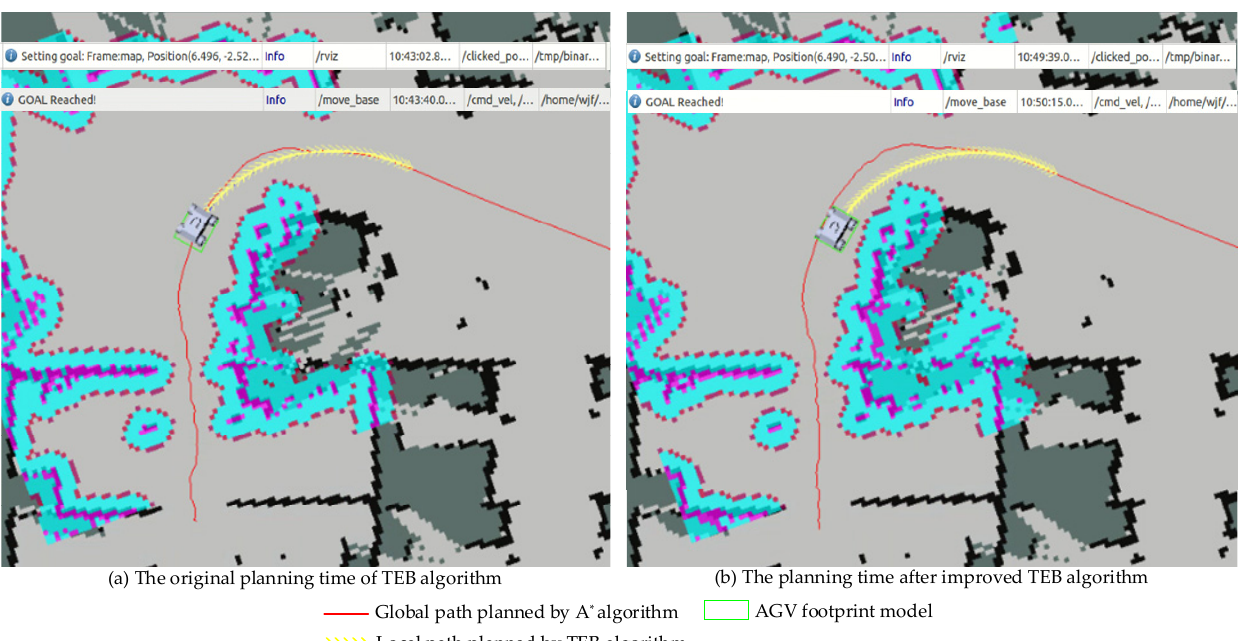
Figure 5. Time comparison of TEB algorithm planning before and after improvement.